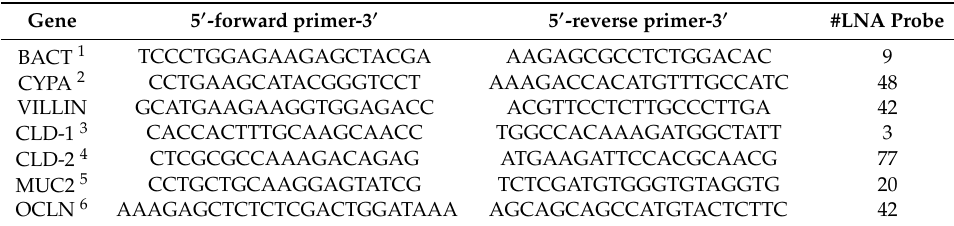
Table 1. LNA probe-based Real-Time PCR